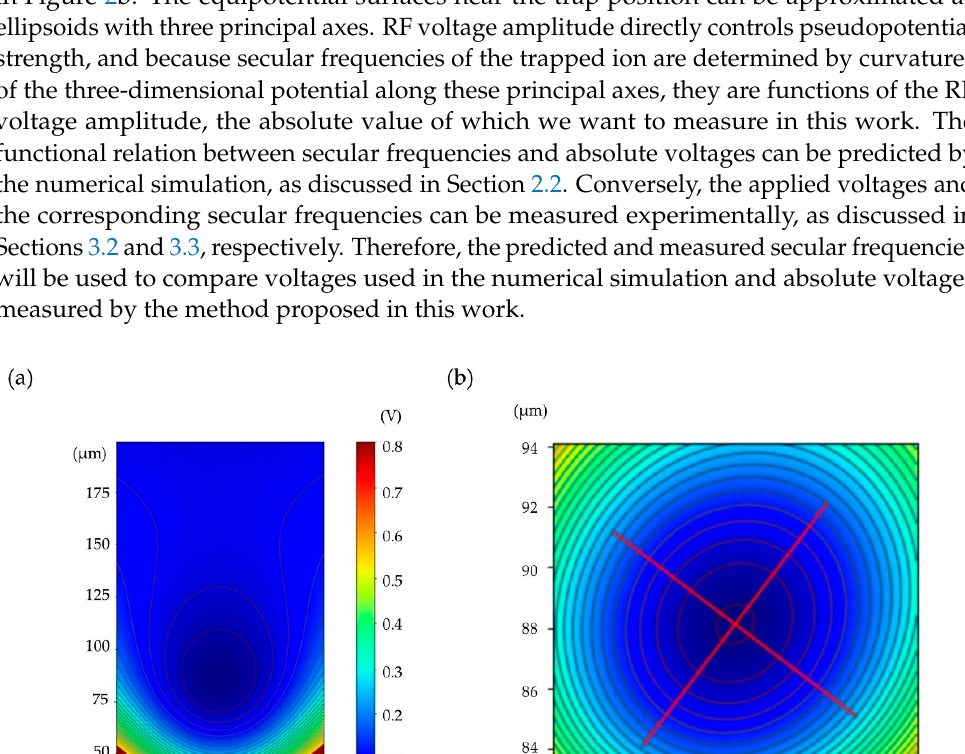
Figure 3. Example contour plot of total potential obtained by numerical simulation of the electrode geometry shown in the dashed red box of Figure 2b. ( a ) Example of total potential generated by voltages on DC and RF electrodes when the amplitude of the RF voltage ( V T ) is 140 V and the frequency is 22.2 MHz which is the same as the experimental condition. DC voltages are shown in Figure 2. ( b ) Magnified view of ( a ) around the potential minimum. Two principal axes of the total potential are plotted at the null point. These two principal axes are intentionally tilted for efficient Doppler cooling. The third principal axis is orthogonal to these two axes and is not shown in this plot.